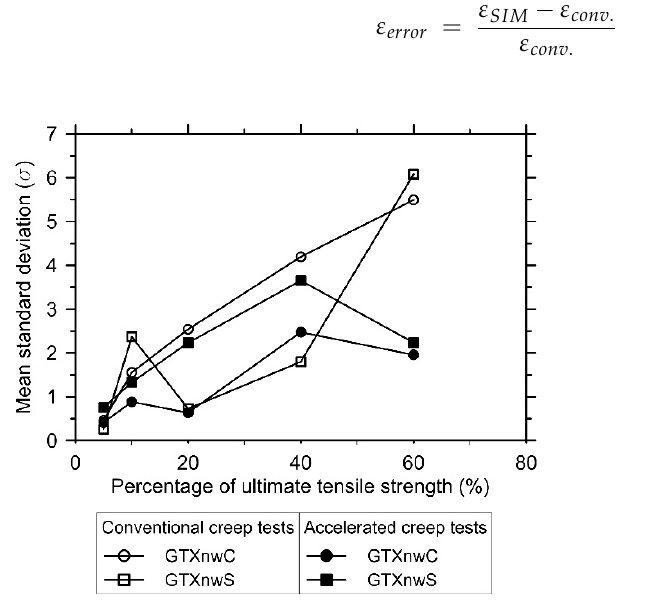
Figure 5. Increase in the mean standard deviation of the axial strain as a function of the load level applied in GTXnwC and GTXnwS specimens submitted to conventional and accelerated creep tests.